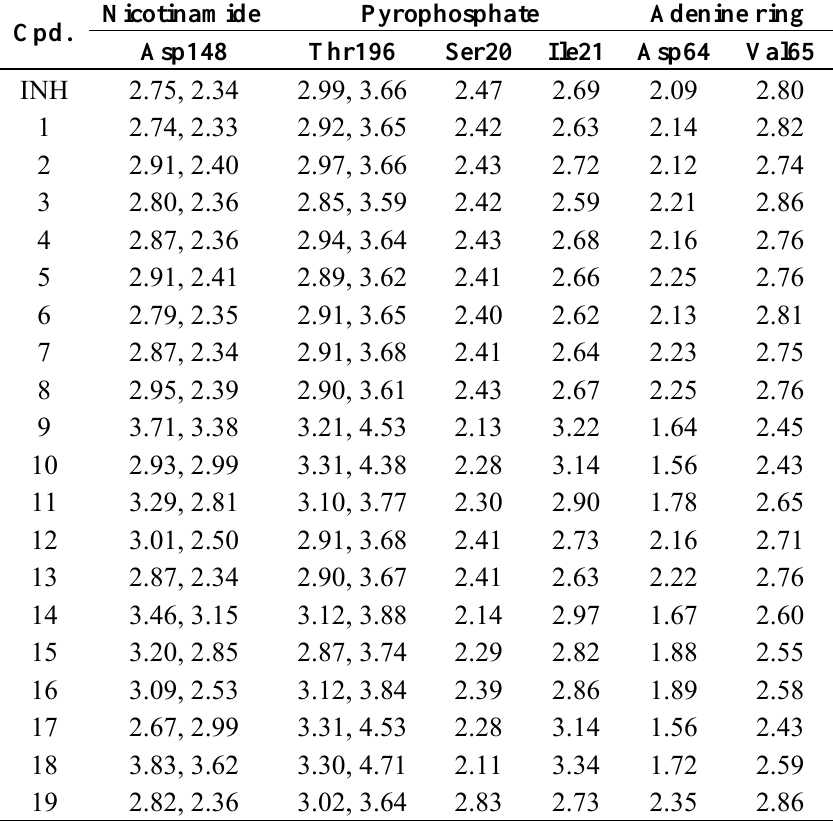
Table 2. The hydrogen bond distances (Å) between the NAD part of all adducts and amino acid residues. Nicotinamide Pyrophosphate Cpd.